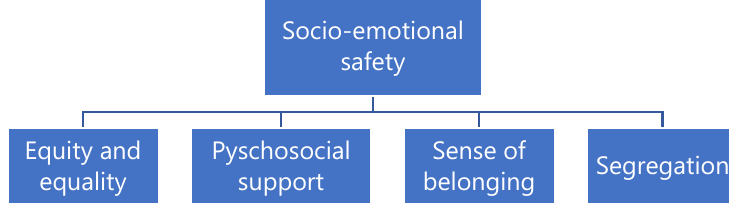
Figure 3. Main theme, socio-emotional safety, and sub-categories.